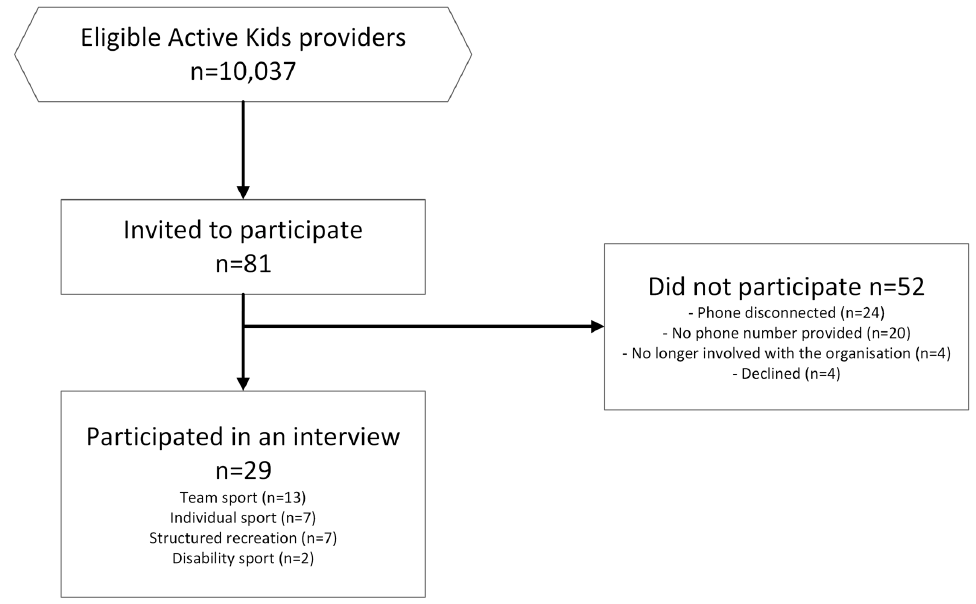
Figure 1. Participant recruitment flow of Active Kids providers.